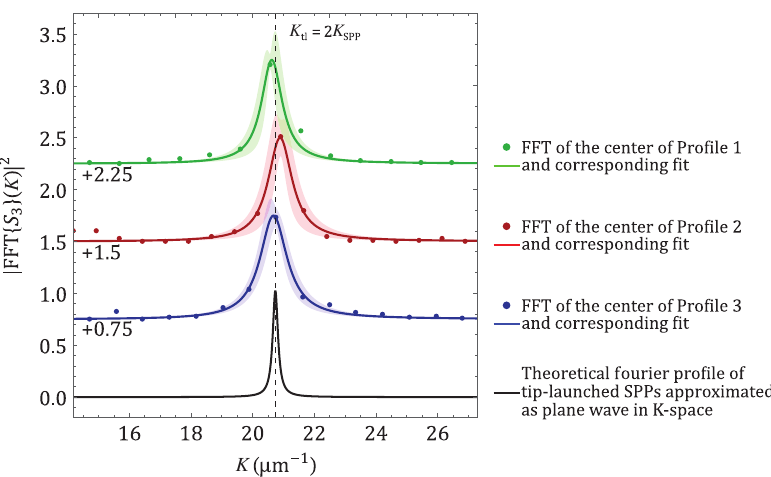
Figure 8: Squared FFT amplitude and corresponding fit of the second subinterval of the three profiles shown in Figure 5 containing only the contribution of tip-launched SPPs (illumination wavelength at 633